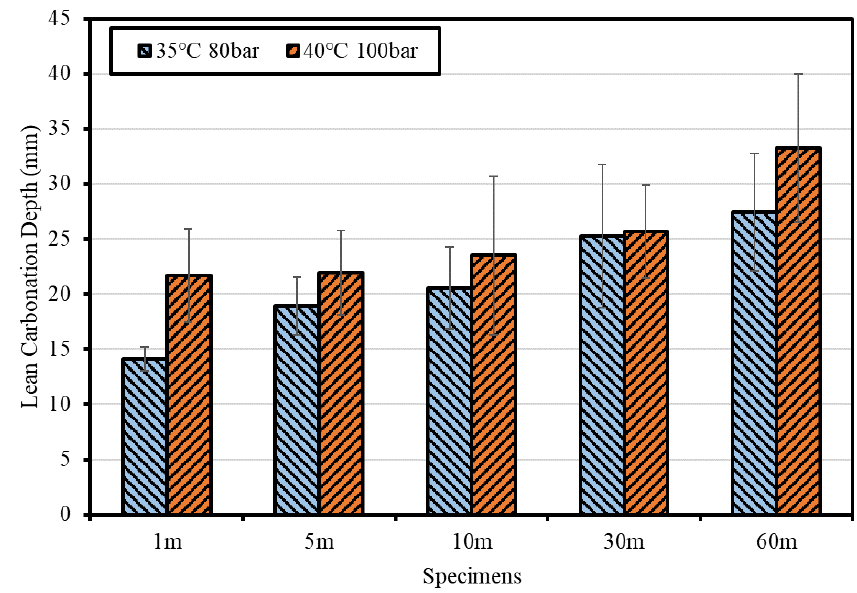
Figure 10. Carbonation depth measurement results after supercritical CO 2 curing.